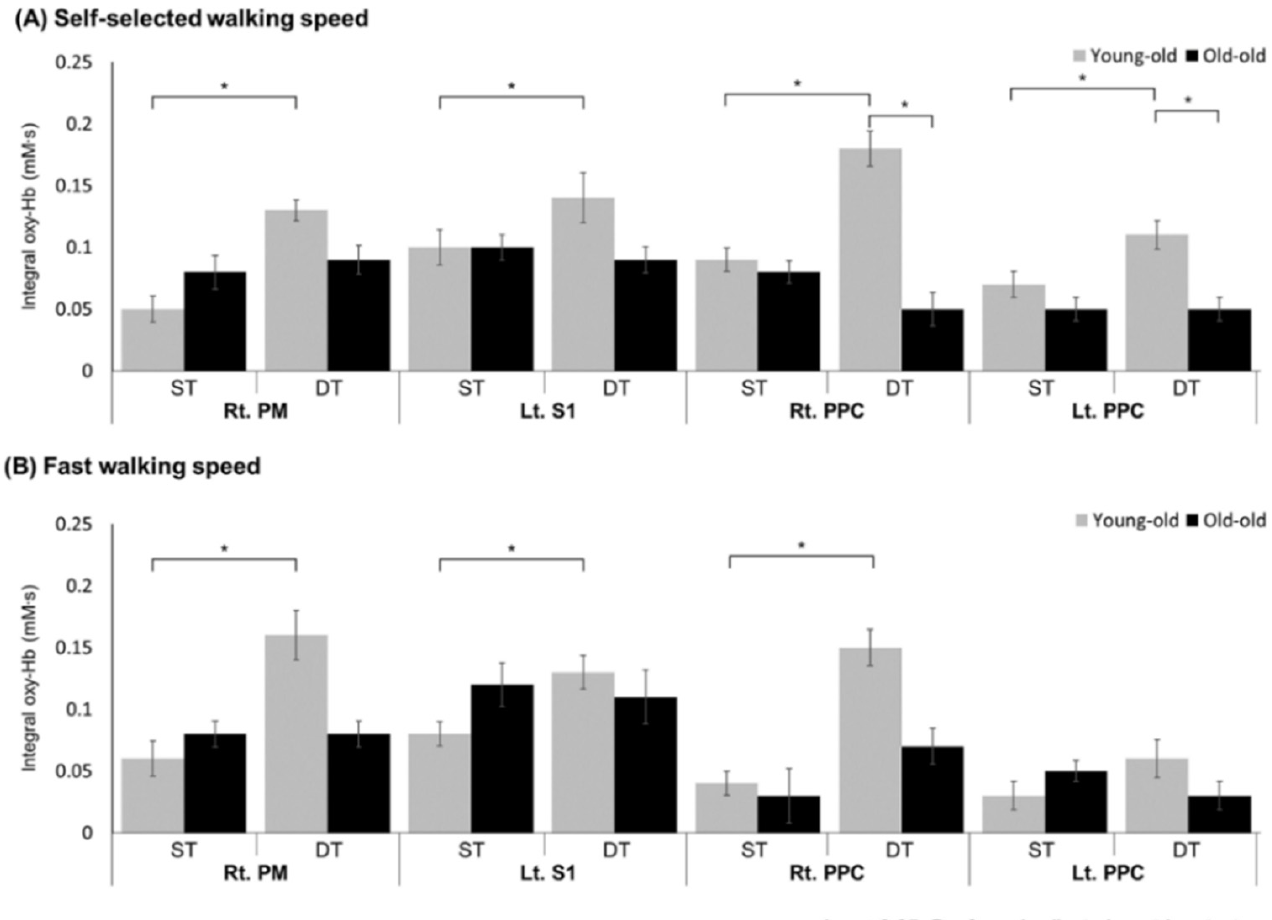
Figure 3. Changes in integral values of oxyHb concentration during walking in the young-old and the old-old. In the young-old, oxyHb significantly increased in the right PM, left S1, and bilateral PPC at both self-selected walking speed ( A ) and fast walking speed (except left PPC) ( B ) during the dual-task walking compared with the single-task. However, there was no change in the old-old elderly. In addition, oxyHb concentration in the bilateral PPC was significantly lower in the old-old elderly compared with the young-old during the dual-task walking. oxyHb, oxyhemoglobin; PM, pre-motor area; S1, primary somatosensory motor cortex; PPC, posterior parietal cortex; ST, single-task; DT, dual-task; Rt., right; Lt., left.